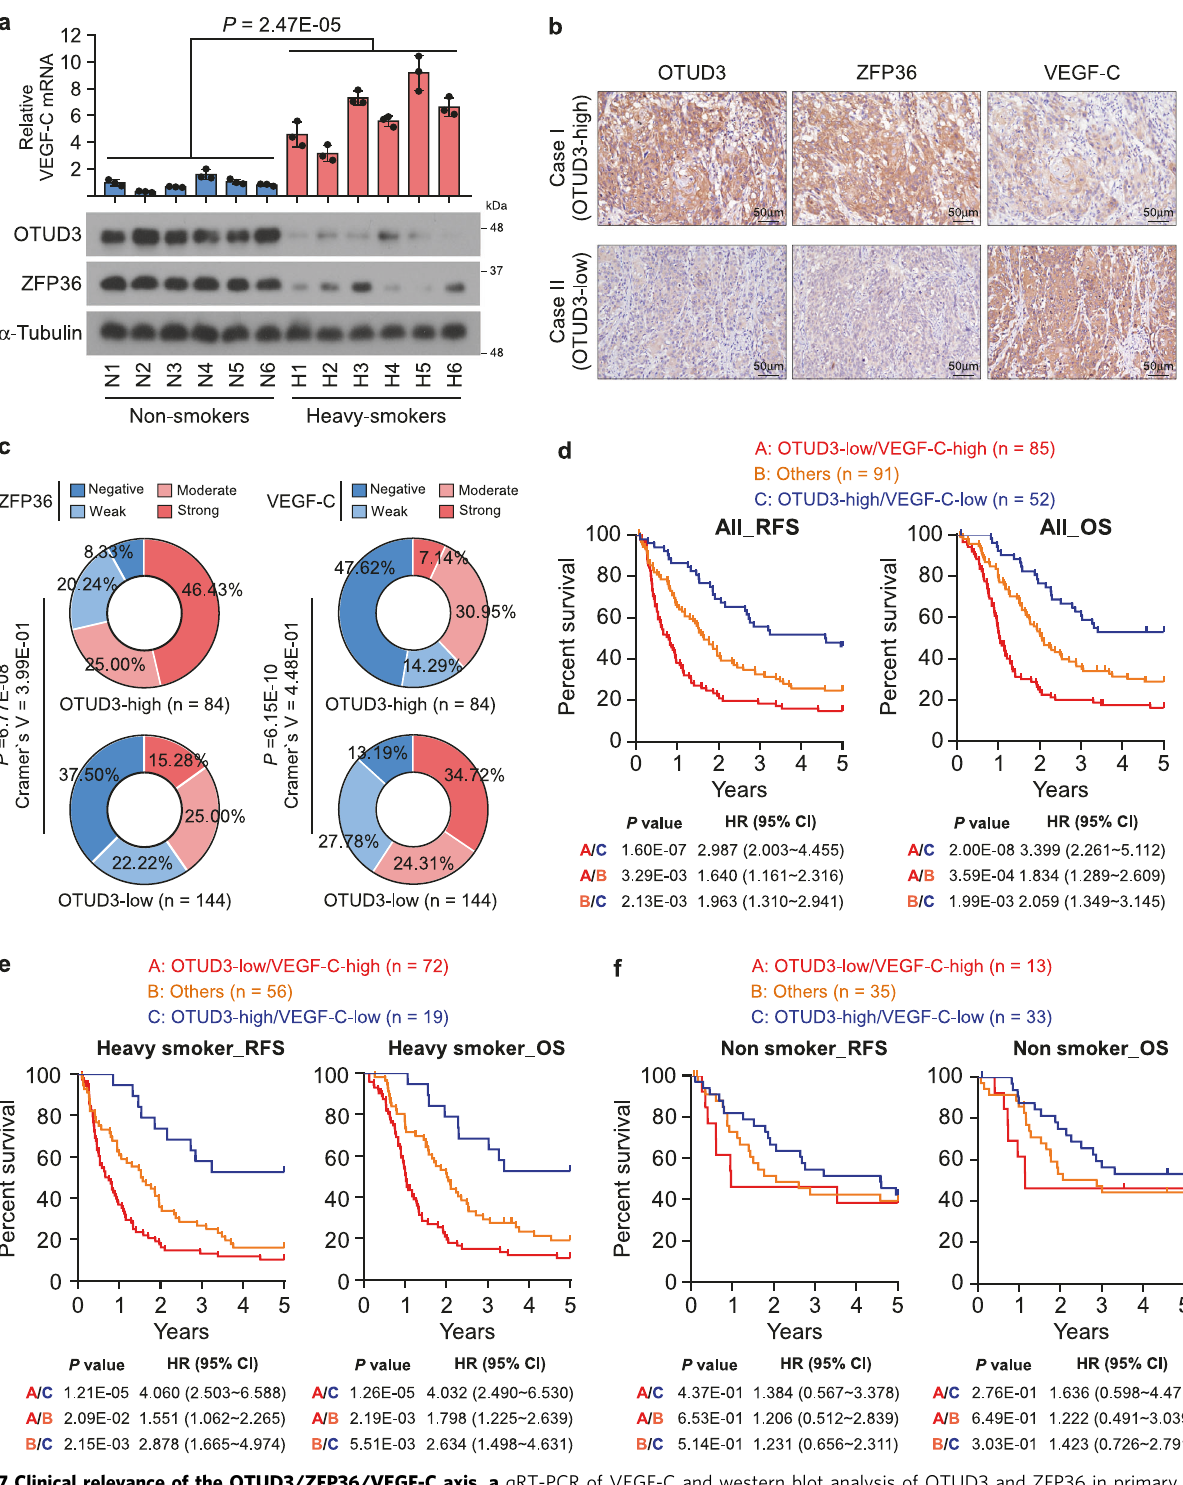
Fig. 7 Clinical relevance of the OTUD3/ZFP36/VEGF-C axis. a qRT-PCR of VEGF-C and western blot analysis of OTUD3 and ZFP36 in primary esophageal tumors derived from six non-smokers and six heavy smokers. Each error bar represents the mean ± SD of three biological replicates. Statistical signi fi cance was determined by one-way ANOVA compared with non-smokers. Immunoblots in this fi gure are representative of three biological replicates. b Representative images of OTUD3, ZFP36, and VEGF-C IHC staining in esophageal cancer patient specimens ( n = 228). Scale bars: 50 µ m. c Correlation analysis showed that OTUD3 was signi fi cantly associated with the expression scores of ZFP36 and VEGF-C. Two-sided χ 2 test and Cramer ’ s V were used to evaluate the correlation. d – f The patient specimens were divided into three groups, including OTUD3-low/VEGF-C-high, OTUD3-high/VEGF-C-low, and others. Kaplan – Meier survival curves and log-rank test were then used to test their signi fi cance in predicting RFS and OS of all ( d ), heavy-smoking ( e ), or non-smoking ( f ) esophageal cancer patients. The relative HRs between different signatures are indicated. Source data are provided as a Source data fi